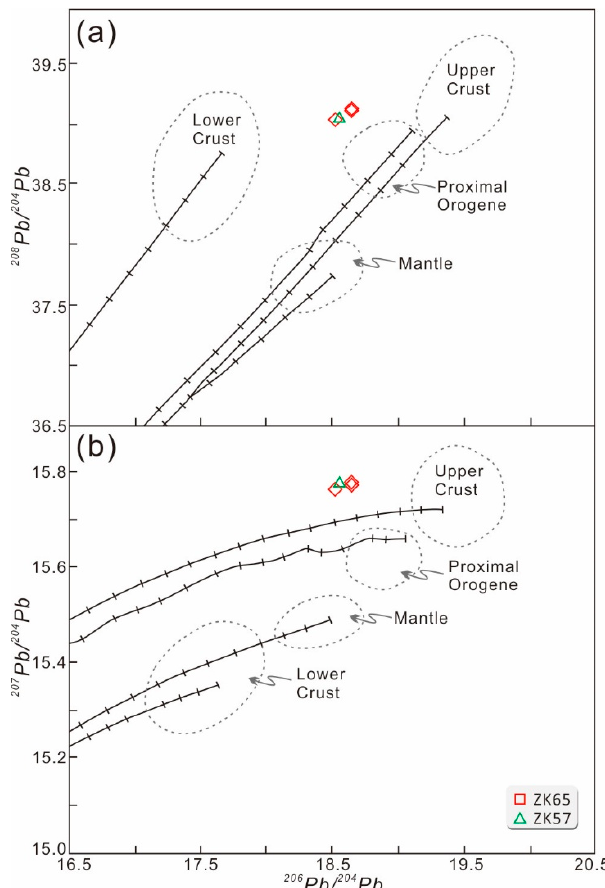
Figure 12. ε Nd (t) vs. ε Hf (t) for the granites from Xianghualing area South China. Plots of ε Nd (t) vs. ε Hf (t) fall into the quadrangle. The average values concentrate in the dotted quadrangle. The data of ε Nd (t) and ε Hf (t) are from [29 – 31,33,54,81,82]. MORB, mid-ocean ridge basalt.